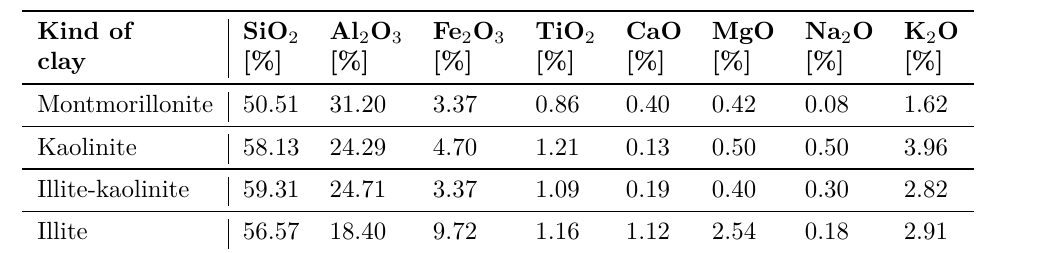
Table 1. Chemical composition of clays.